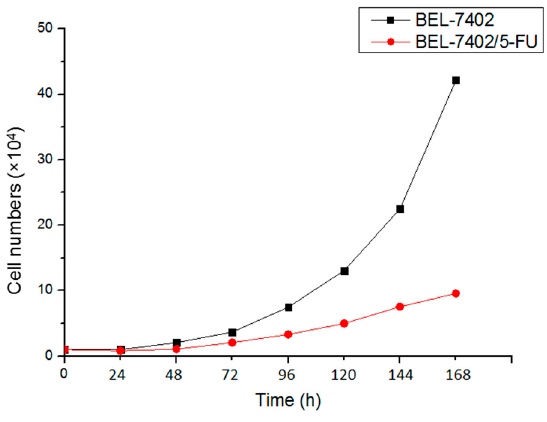
Figure 1. Doubling time of BEL-7402 and BEL-7402/5-FU cells.